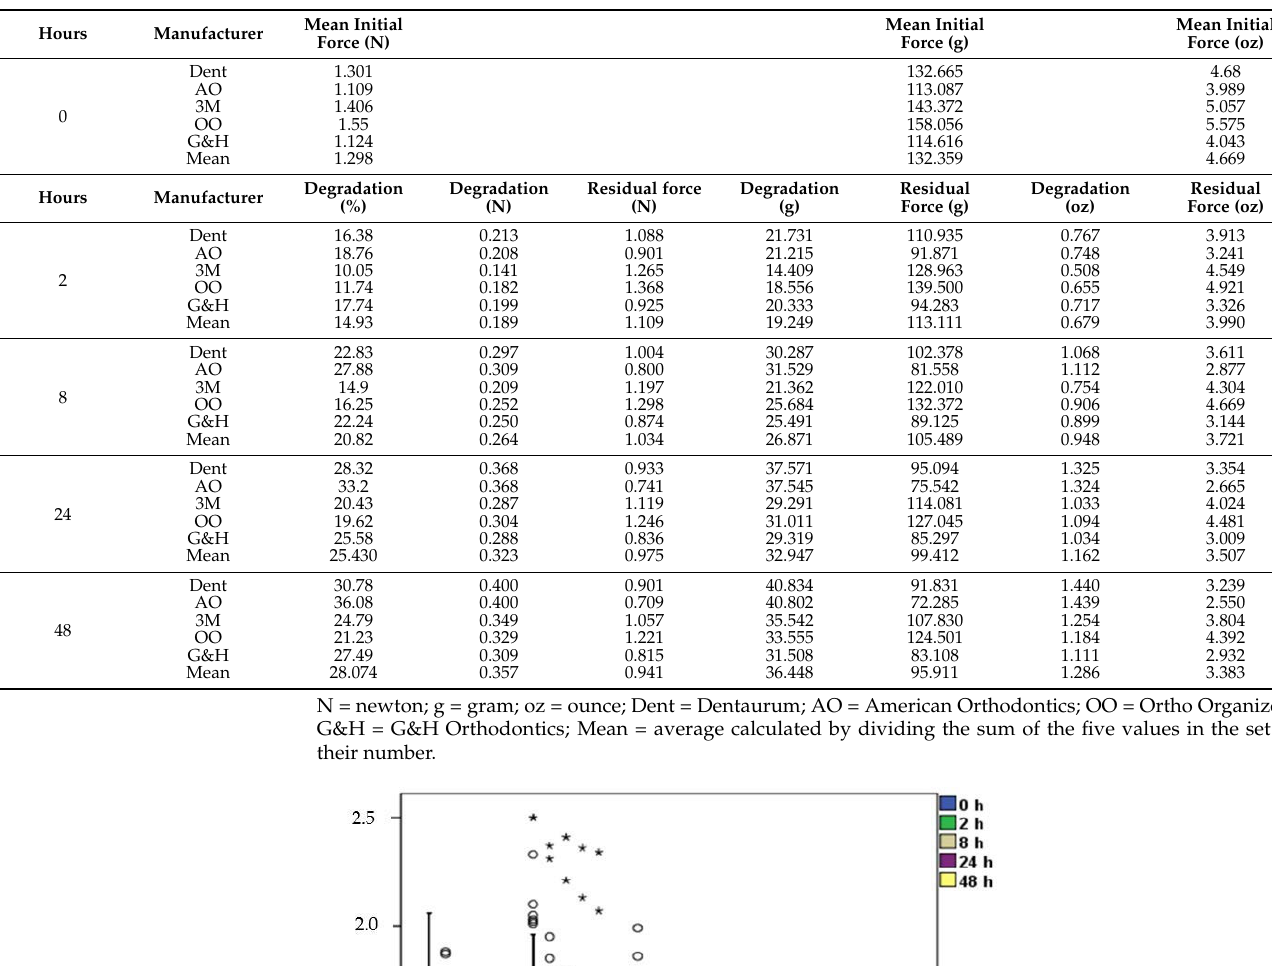
Table 3. Initial forces at 0 h in newtons, grams, and ounces calculated using the following formula: 1 N = 101.9716212978 gf (gram force); 1 oz = 28.3495231 g. Force degradation at 2, 8, 24, and 48 h is shown as a percentage of the initial force, in newtons, grams, and ounces. Residual force at 2, 8, 24, and 48 h is displayed in newtons, grams, and ounces.